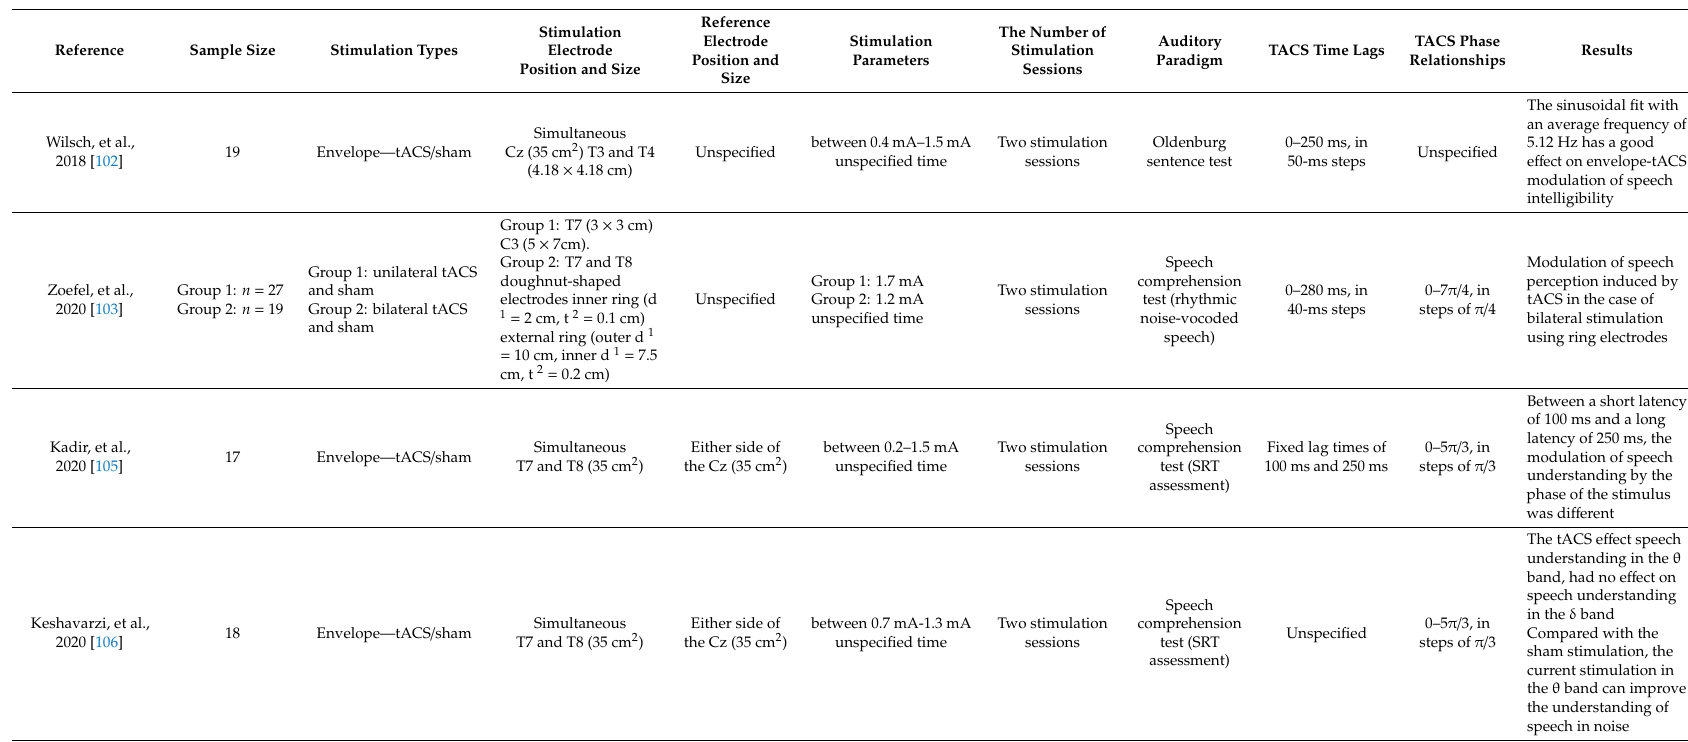
Table 4. Partial parameters, paradigm and results of tES e ff ect speech understanding